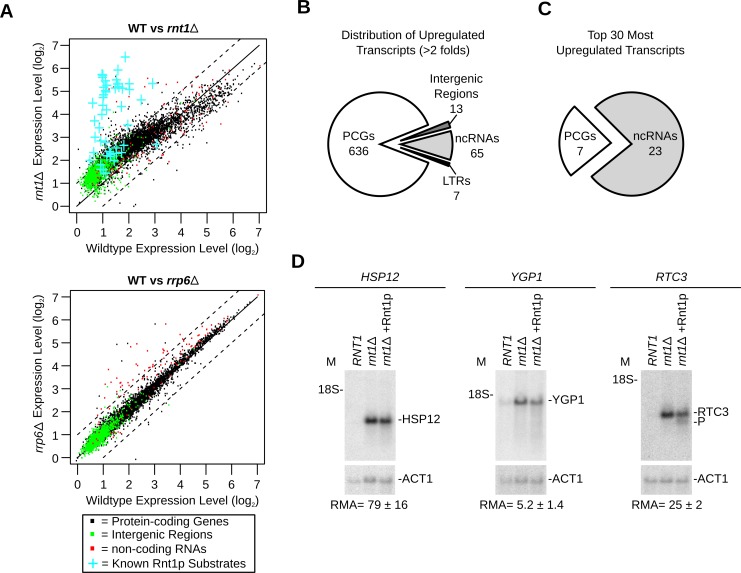
Gene expression is a poor indicator of substrate reactivity.(A) Deletion of RNT1 induces global perturbation of the yeast transcriptome. The levels of gene expression in wild type (WT) cells, rnt1∆ (top) and rrp6∆ (bottom) strains were determined using tiling arrays covering the entire yeast genome and presented in the form of dot plot comparison. Dots corresponding to the expression values of protein-coding genes, non-coding RNA and intergenic regions are shown in black, red and green, respectively (S7 Table). Blue crosses highlight the expression of the known Rnt1p substrates as indicated in Fig. 1A. (B) Rnt1p regulates the expression of both coding and non-coding genes. Pie chart illustrating the types of RNAs upregulated by at least two folds upon RNT1 deletion (details in S9 Table). Multiple transcripts within the same overexpressed segments were counted individually. PCGs, ncRNAs and LTRs indicate protein-coding genes, non-coding RNAs and long terminal repeats, respectively. (C) Expression of non-coding RNAs (ncRNAs) is highly sensitive to RNT1 deletion. The top 30 upregulated genes in rnt1∆ cells were sorted according to their RNA types (details in S10 Table). (D) RNAs upregulated by the deletion of RNT1 resist cleavage in vitro. Northern blot analysis of RNA extracted from wild type (RNT1) and rnt1∆ cells before and after incubation with Rnt1p (rnt1∆+Rnt1p) was performed as described in Fig. 1G. Cleavage was visualized using probes complementary to the sequence of HSP12 (left), YGP1 (middle) or RTC3 (right) mRNAs.